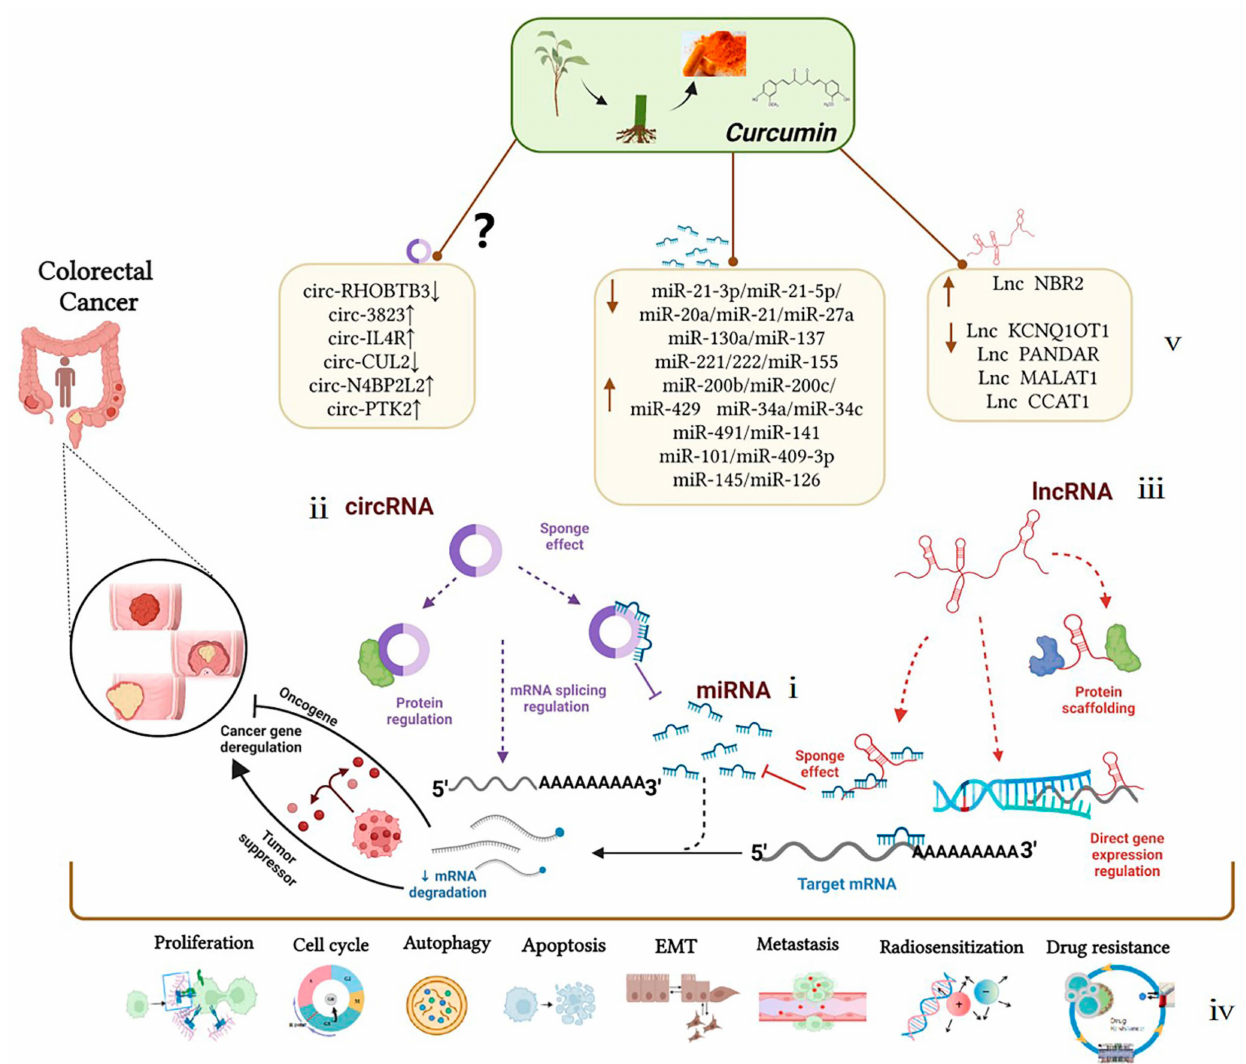
Figure 2. Mechanism of curcumin-targeted regulation of non-coding RNAs against colorectal cancer. Dotted lines represent different regulation methods; boxes represent different ncRNAs regulated by